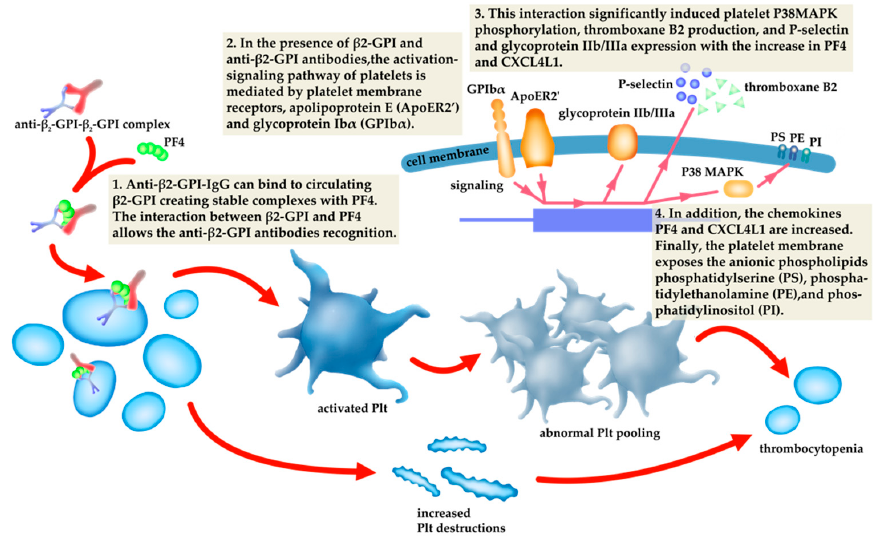
Figure 2. The relationship of the pathogenesis of thrombocytopenia to antiphospholipid antibod- ies (aPLs).